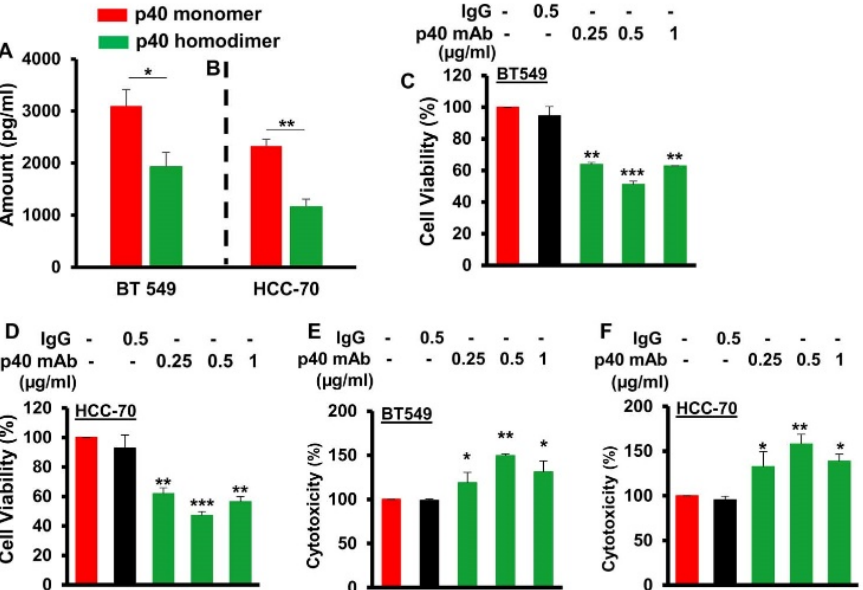
Figure 2. Monoclonal antibody ‐ mediated neutralization of p40 induces death of different human TNBC cells. Levels of p40 and p40 2 were measured in supernatants of human TNBC cells ( A , BT ‐ 549; B , HCC70) by ELISA. Results are mean ± SD of three different experiments. * p < 0.05; ** p < 0.01 . BT ‐ 549 ( C , E ) and HCC70 ( D , F ) cells were treated with p40 mAb for 24 h under serum ‐ free condition followed by monitoring MTT metabolism ( C , D ) and LDH release ( E , F ). Results are mean ± SD of three separate experiments. * p < 0.05 ; ** p < 0.01; *** p < 0.001 .